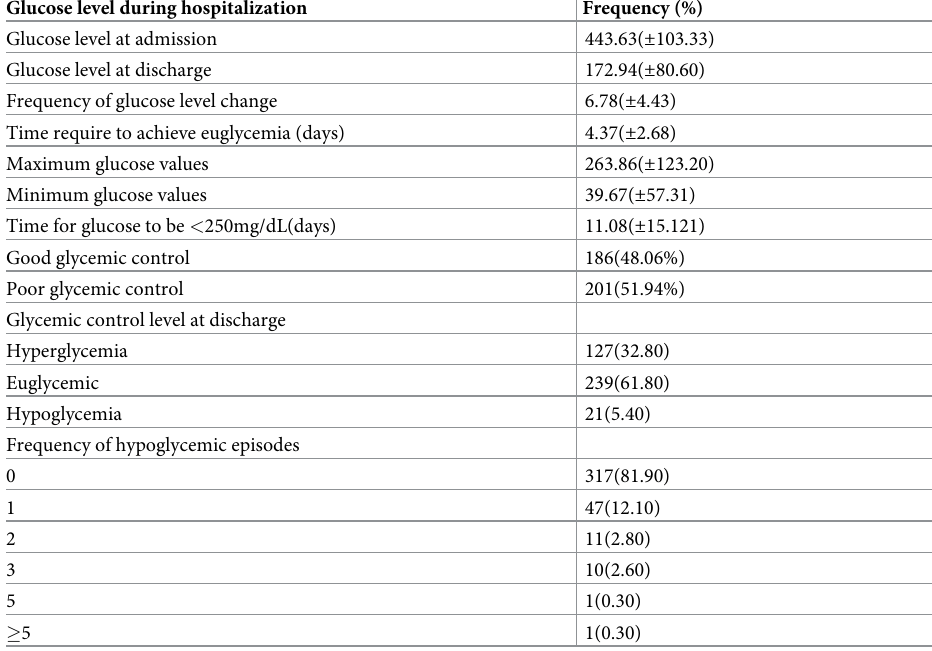
Table 4. Glucose level during hospitalization in DKA patients at DTGH from August 2010 to May 31, 2018 (n =